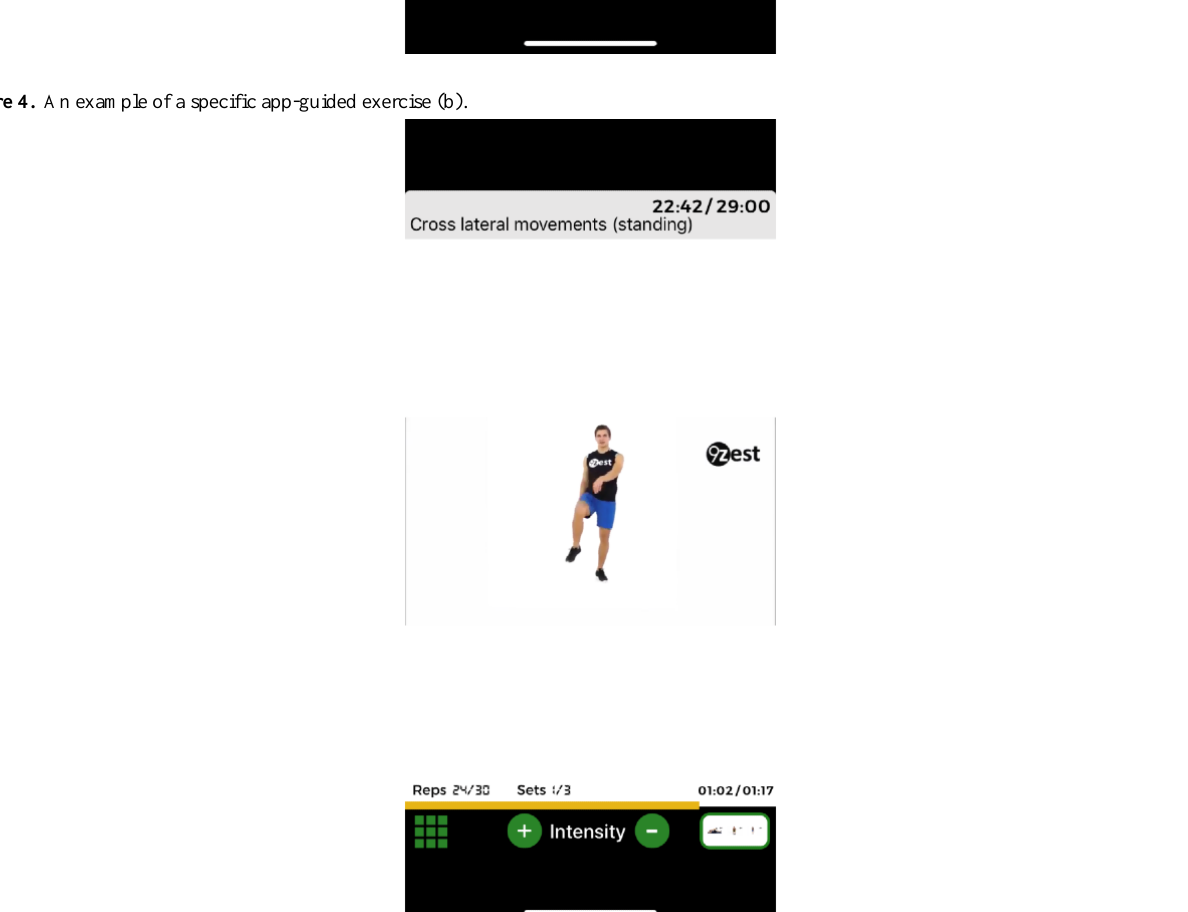
Figure 4. An example of a specific app-guided exercise